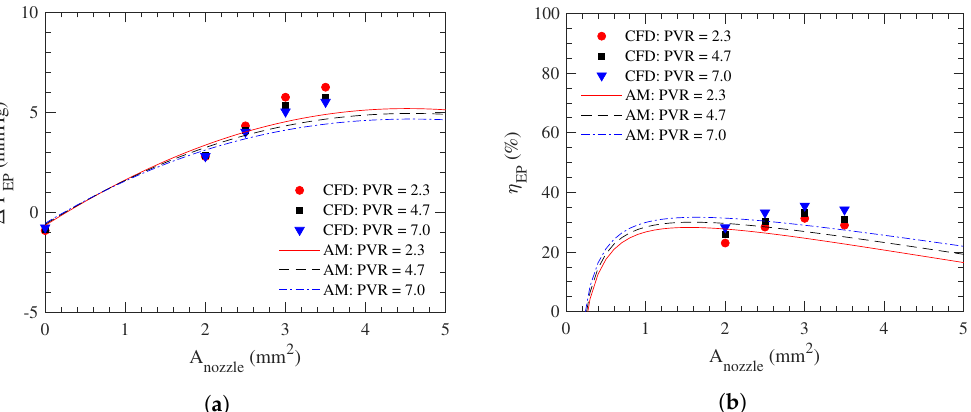
Figure 10. ( a ) The pressure recovery, ∆ P EP ; and ( b ) ejector pump efficiency, η EP , as a function of nozzle area, A nozzle , at different PVR values. Lines correspond to the algebraic model (AM) and symbols to the CFD.